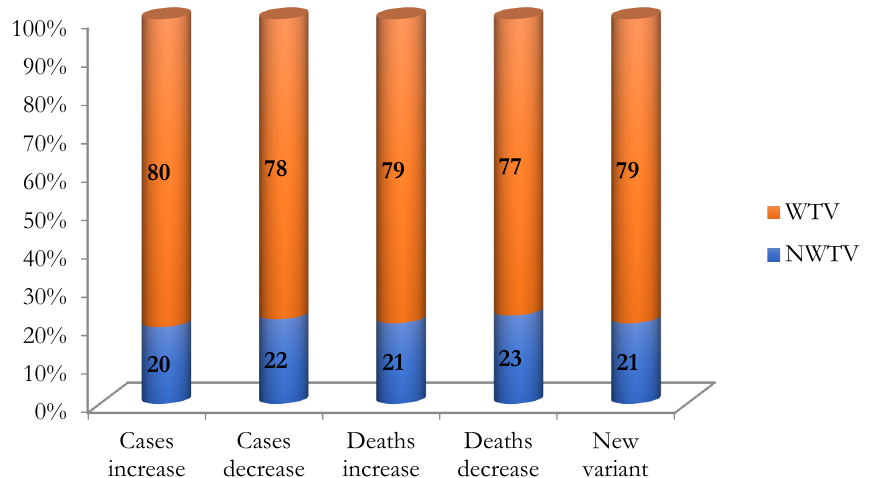
Figure 3. COVID-19 vaccine acceptance with different levels of pandemic severity. Source. Drawn by the authors using surveyed data. Note. WTV: Willing to be vaccinated, NWTV: Not willing to be Table 1. COVID-19 vaccine acceptance with different levels of pandemic severity.